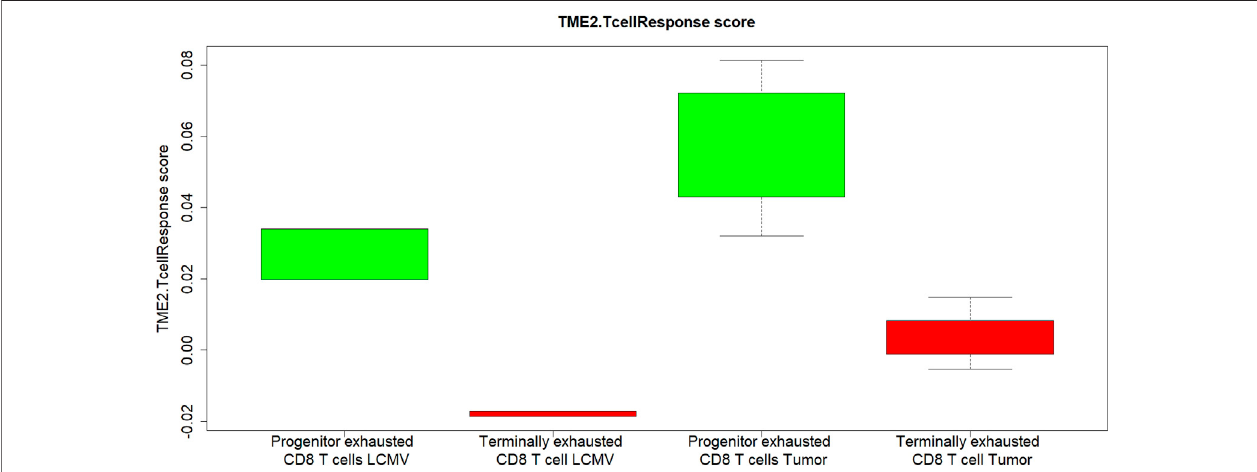
FIGURE3| Inbothtumorandchronicviralinfection,CD8 + Tcellscomponentsof TME 2 . TcellResponse signi fi cantlycorrelateswithanti-PD1respondingprogenitor exhausted CD8 + T cells ( p (cid:1) 0.048, 0.001, respectively). The X -axis is the groups of CD8 + T cells. Green is the puri fi ed progenitor exhausted CD8 + T cells; red is the puri fi ed terminally exhausted CD8 + T cells. Y -axis is the TME 2 . TcellResponse score calculated using CD8 + T cells components of TME 2 . TcellResponse